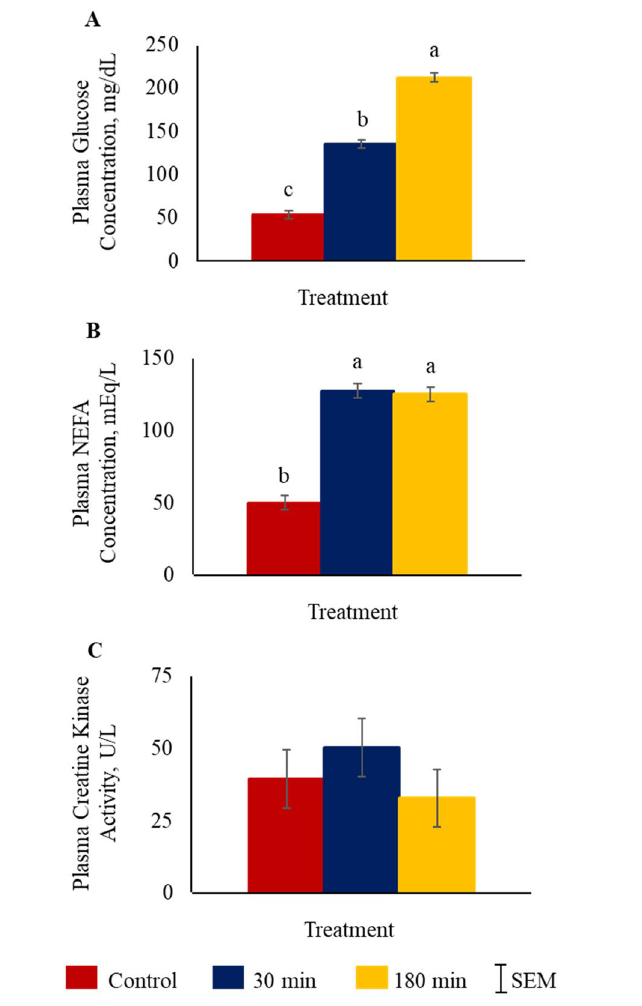
Figure 2. Effects of stress treatment (Control = not transported but held in pens; 30 min = transported for 30 min; 180 min = transported for 180 min) on mean ± SEM plasma ( A ) glucose and ( B ) non-esterified fatty acids (NEFA) concentrations, and ( C ) creatine kinase activity in